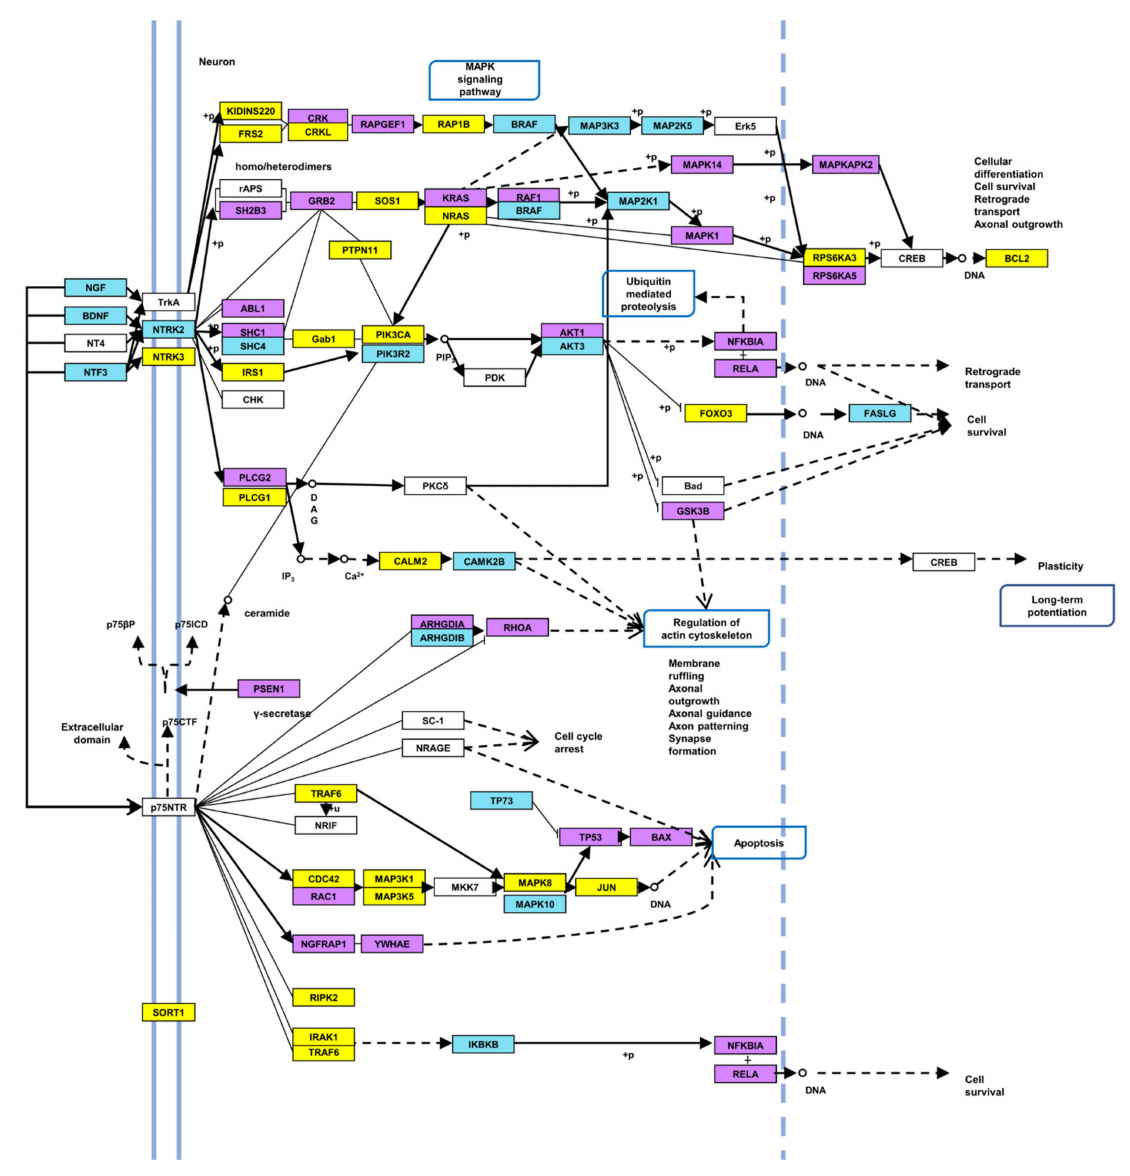
Figure 3. Target genes of significant miRNAs in neurotrophin signaling pathway. Colors of boxes as follows: blue: predicted target genes from DIANA-microT analysis; violet: experimentally- supported target genes from DIANA-TarBase analysis; yellow: target genes identified by both DIANA-microT and TarBase algorithms; white: genes not identified as target of significant miRs here described.Arrows as follows: regular line: molecular interaction or relation; dotted line: indirect link or unknown reaction. Modified from DIANA